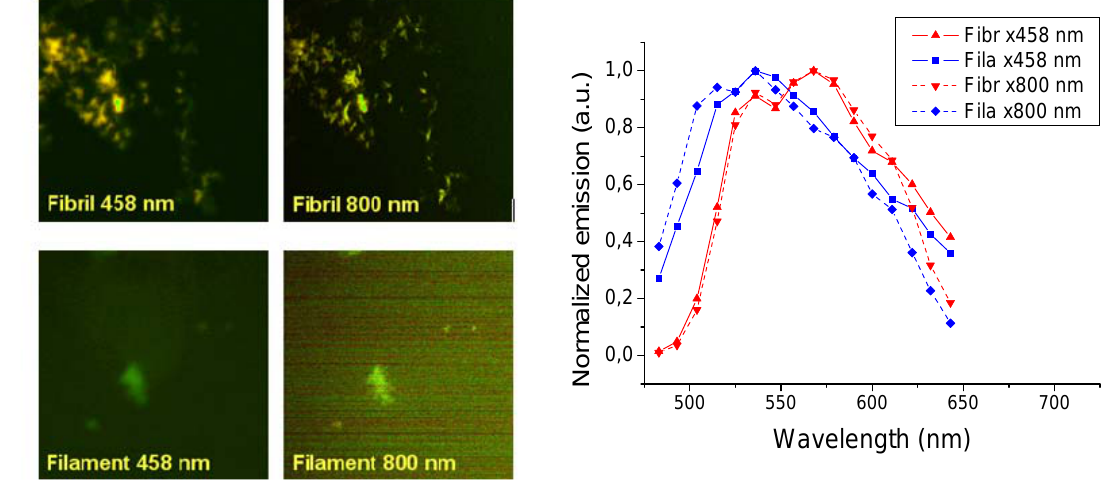
Figure 6. Images for h -HTAA associated to fibrillar and filamentous amyloid insulin for one- and two-photon excitation. Right graph: Emission spectra associated with a series of